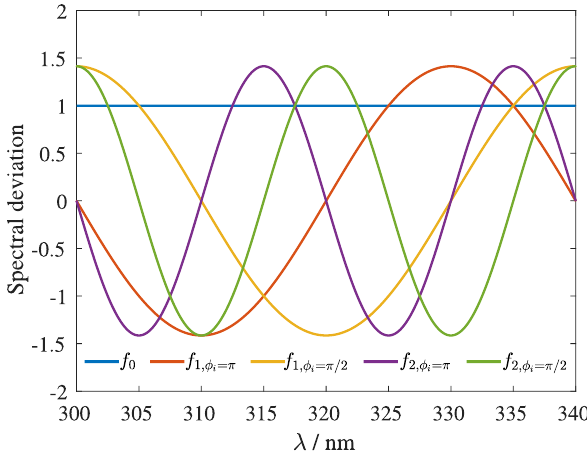
Figure 4. First three base functions with unity variance, f 1 and f 2 plotted with the phases φ i = π and φ i = π/